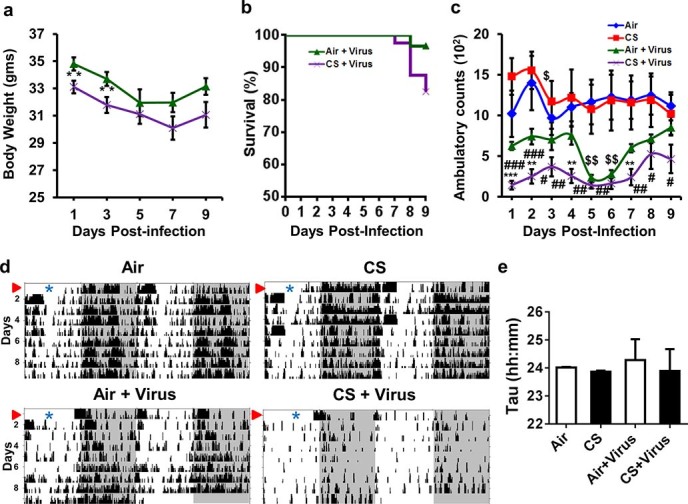
Influenza A virus infection differentially affects body weight, mortality and
behavior in chronic air or CS-exposed mice.Data from uninfected air- and CS-exposed mice from a previous experiment were
included for comparison [panels c–e;30]. (a) Chronic CS-exposed mice infected
with IAV showed a modest reduction in weight, marked by a decline on days
1–3 post-infection relative to air-exposed mice infected with
IAV. (b) Mortality was monitored for 9 days post IAV infection. Data
are representative of mean ± SEM (n = 30–40
mice/group). ** P < 0.01 significant compared to Air+Virus
group. Analysis of differences in survival over time was determined by a
Mantel-Cox test (P < 0.68). (c) Nocturnal activity
for 9 days post-infection was plotted as ambulatory counts. IAV infection
reduced locomotor activity in CS-exposed mice by 70–80% during
days 1–7 post-infection when compared to CS-exposed mice treated
with saline. Similarly, IAV infection reduced locomotor activity in
CS-exposed mice by 70–80% on days 1–2 and day 4
post-infection but only 30–45% during days 5–9
post-infection when compared to Air+Virus treated mice. Data are mean
± SEM (n = 6 mice/group) for each time point. ** P
< 0.01; *** P < 0.001 significant compared to
control groups (air or Air+Virus); $$ P <
0.01 significant compared to air-exposed mice; #
P < 0.05; # #
P < 0.01; # # # P < 0.001
significant compared to CS-exposed mice. (d) Representative double
plotted actograms of total cage activity from chronic air, chronic CS,
Air+Virus and CS+Virus treated mice. In panel d, gray shading
indicates the dark phase (ZT12-24) and activity was not recorded during body
weight measurements (ZT5-6). Red arrow head indicates day 0 IAV infection
and asterisks denotes the time during which the mice were infected with IAV
(ZT4-6). (e) Periodogram analysis of activity in L:D during days
1–8 post IAV infection. Period was very similar between air and
CS groups, whereas the Air+Virus and CS+Virus groups showed increased
variation in period though the mean was not significantly different from
controls. Data are mean ± SEM (n = 6 mice/group).